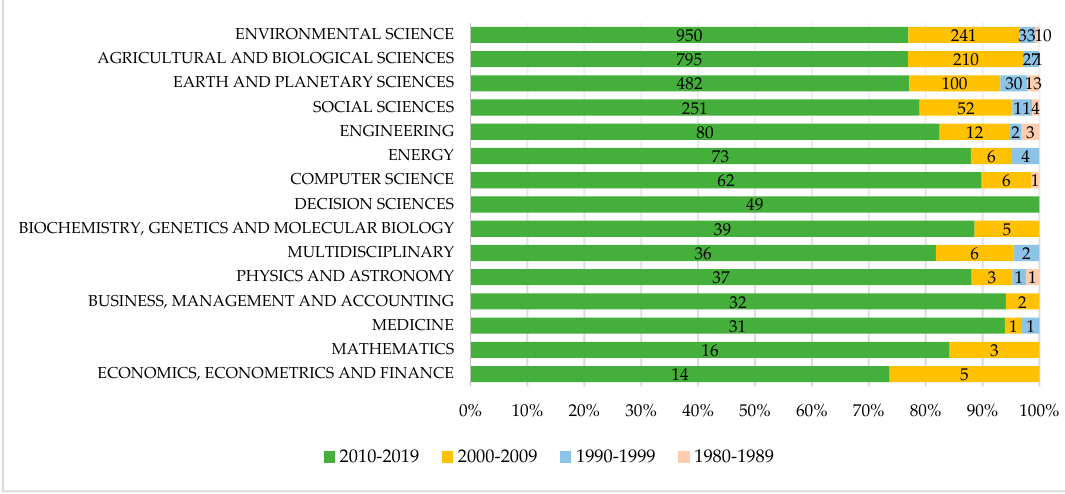
Figure 3. Top 15 Subject areas by period (1980–2019).